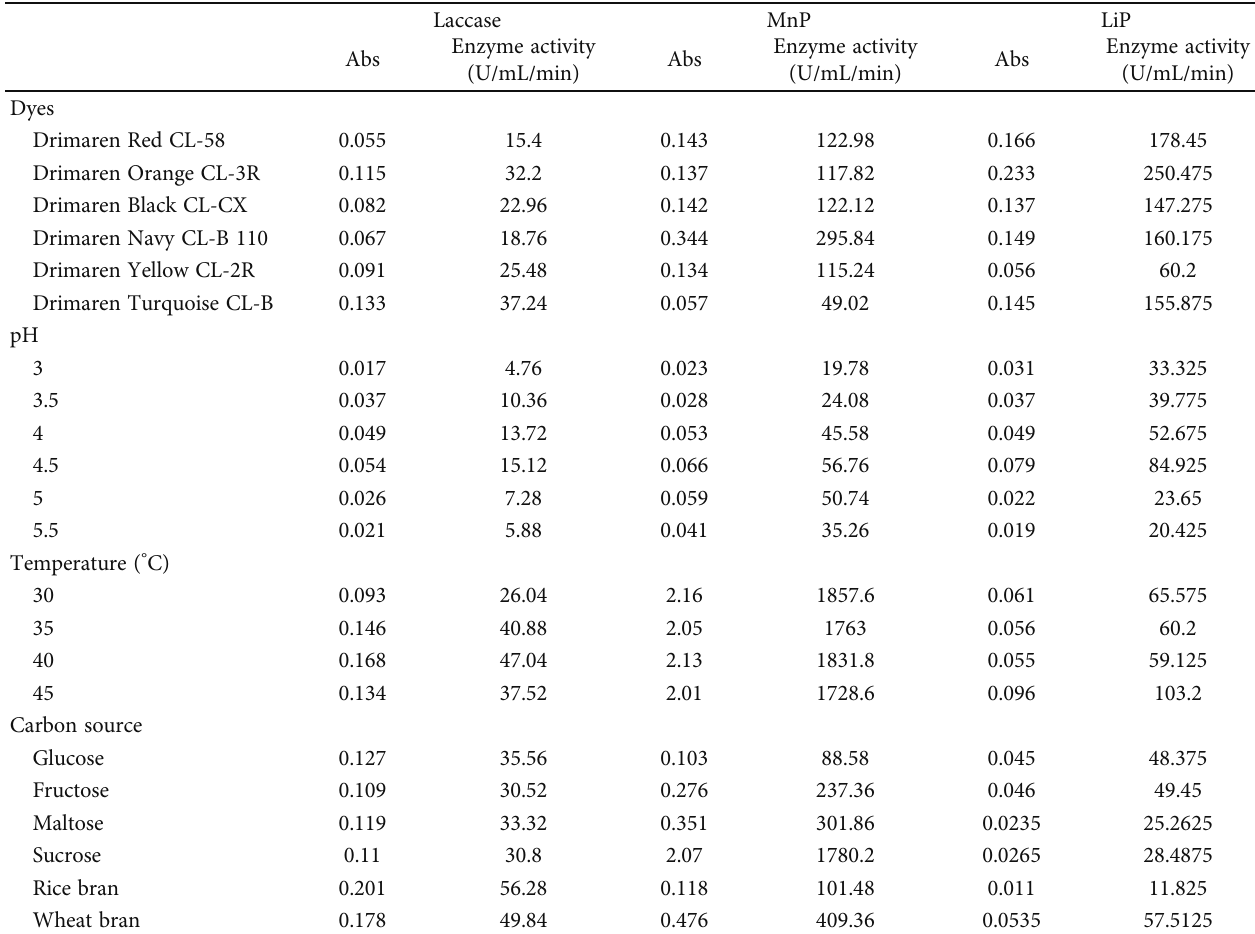
Table 3: Enzyme assay for dye screening experiment along with the e ff ect of pH, temperature and carbon source. Laccase MnP LiP Enzyme Abs